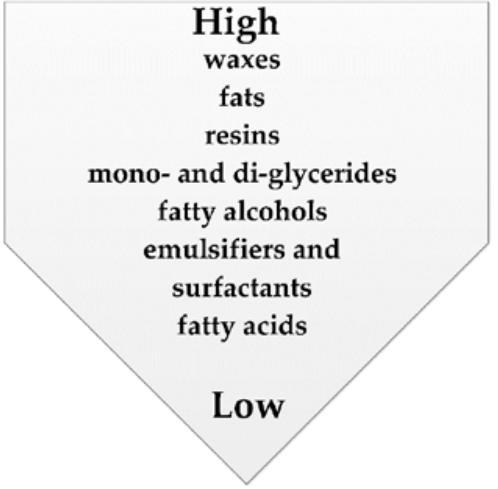
Figure 16. Substances used for obtaining lower values of WVP ranked in terms of hydrophobicity. Oxygen and CO 2